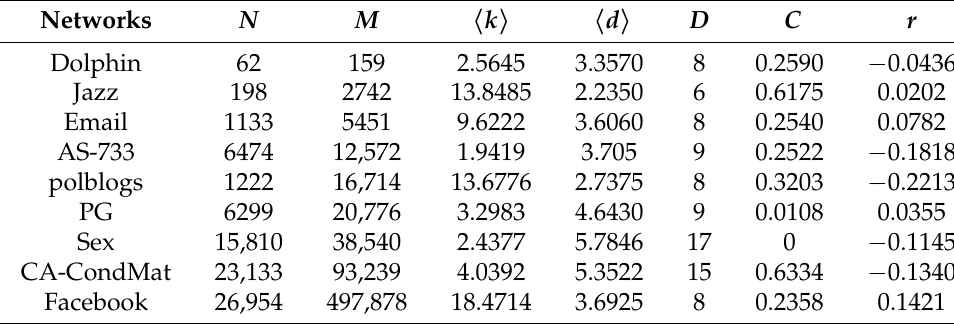
Table 4. The basic topological features of 9 real